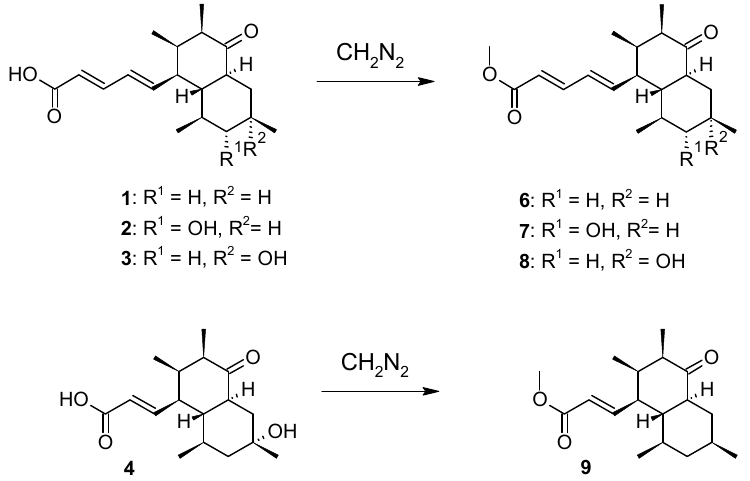
Figure 5. Semisynthetic conversion of elsinopirins A–D ( 1 – 4 ) into their methyl esters 6 – 9 .